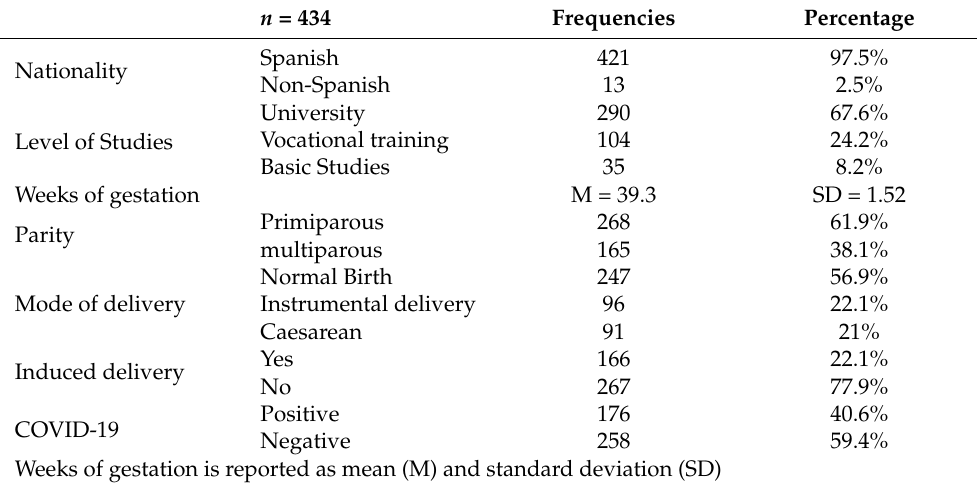
Table 1. Baseline characteristics of studied